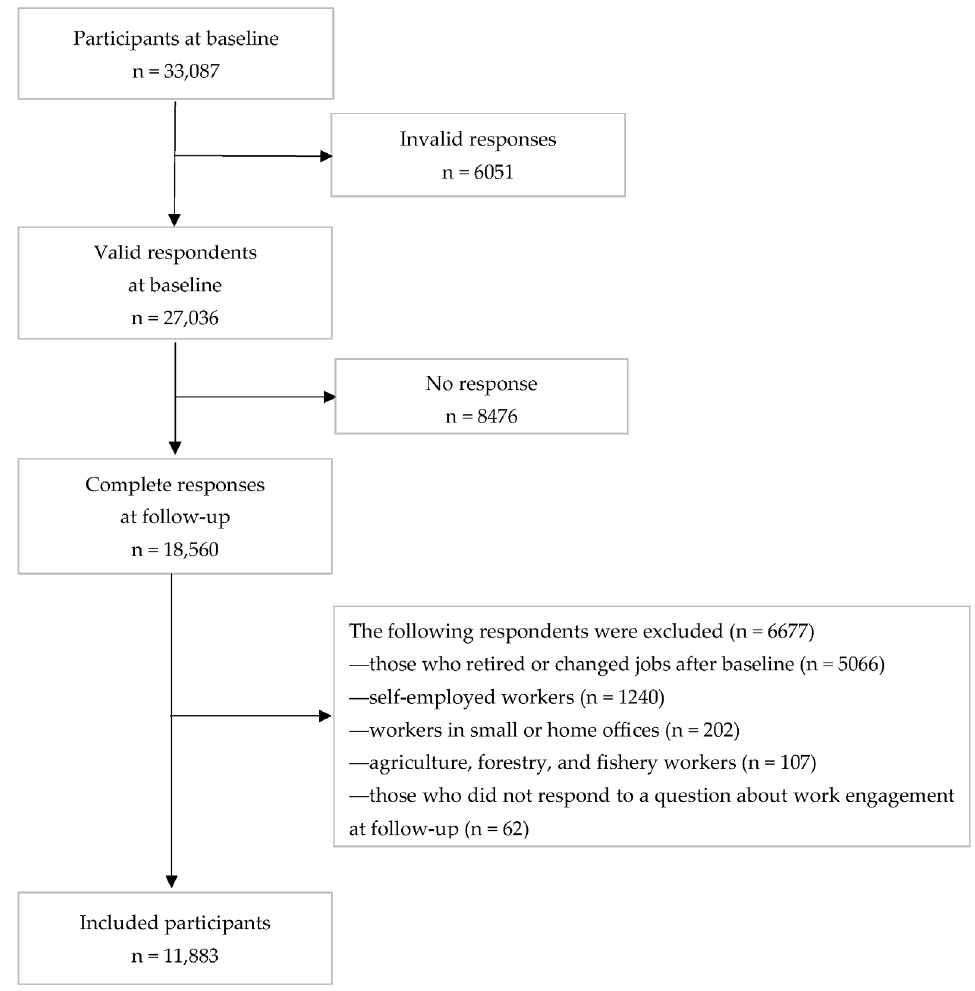
Figure 1. Flow chart for the study.